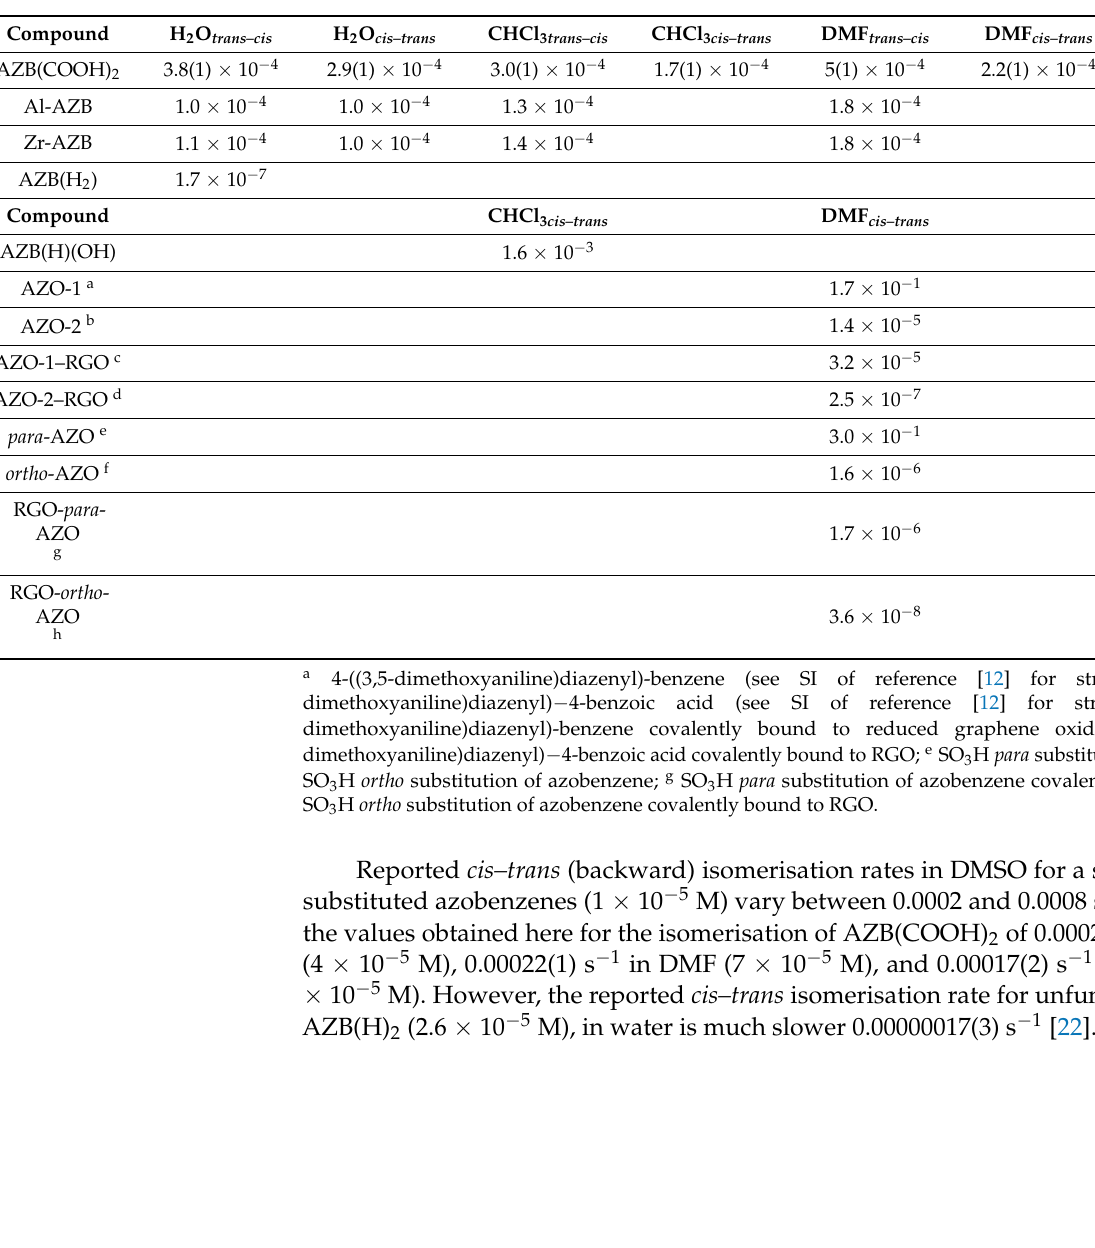
Table 1. Cis–trans (backward) and trans–cis (forward) conversion rate constants (k obs in in s − 1 ) obtained for the indicated compounds in different solvents in this study and